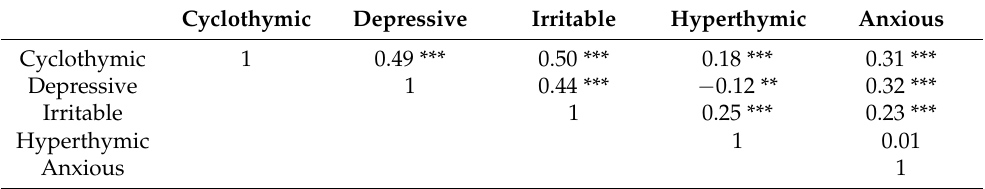
Table 4. Spearman’s correlation results of 5 temperaments in the TEMPS-A (short version).